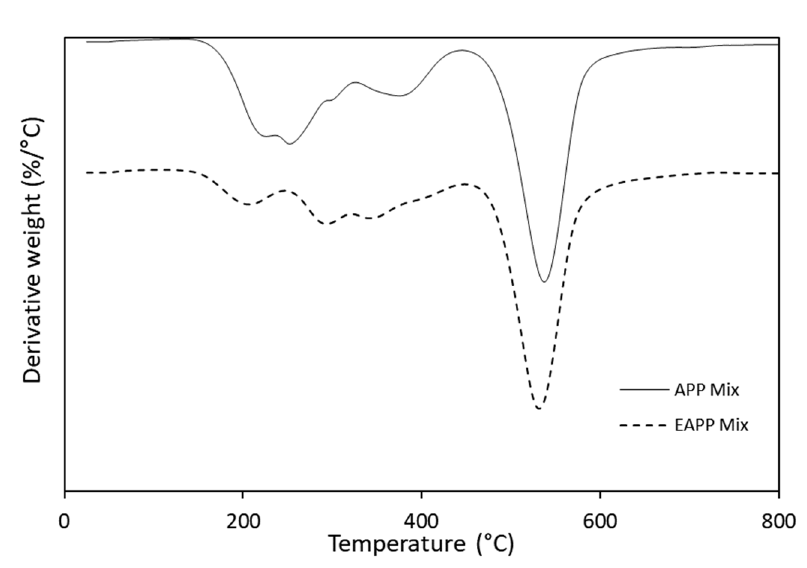
Figure 5. DTG curves of the intumescent powder blends.